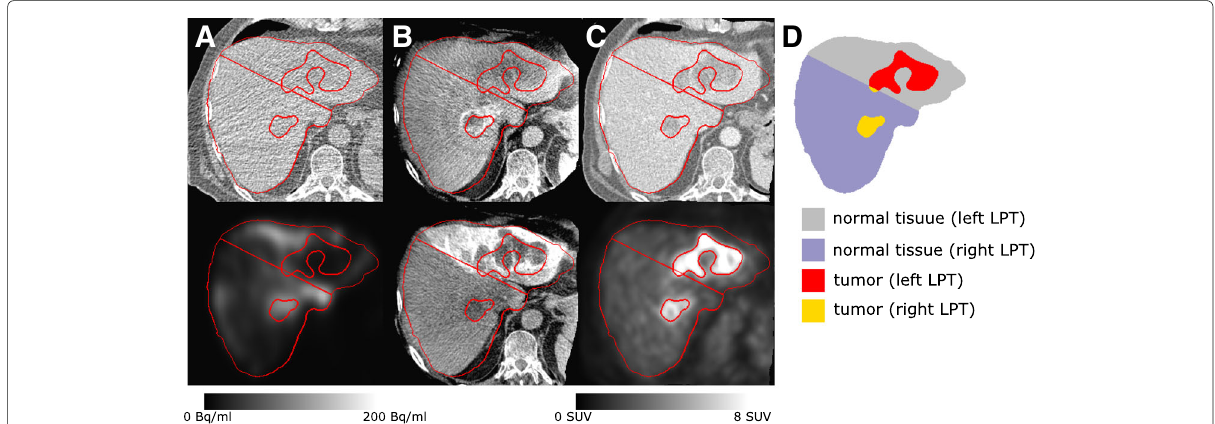
Fig. 1 Single transaxial slice of radioembolization pre-treatment studies and segmentation result (patient ID BI01 from training set in our database): a the CT and activity image of the 99m Tc-MAA SPECT/CT scan. Correction for scatter and attenuation is applied and a phantom-based calibration factor is used to obtain images of absolute 99m Tc concentration [kBq/cc]. b CBCT images with contrast enhancement facilitating delineation of the right and left liver lobe. c The CT and PET of the 18 F-FDG PET/CT study. d The segmented liver, tumor, and